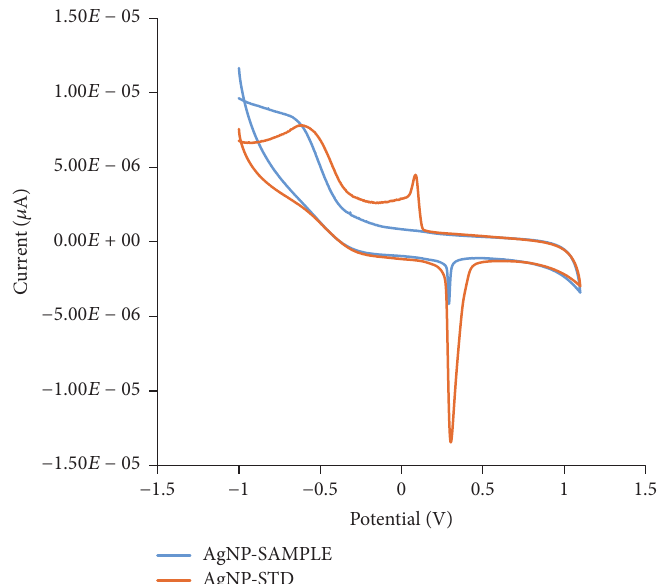
Figure 8: Overlay of cyclic voltammograms of standard reference AgNPs (0.02mg/mL, 20 nm AgNPs colloidal dispersion) and WMRE- AgNPs.